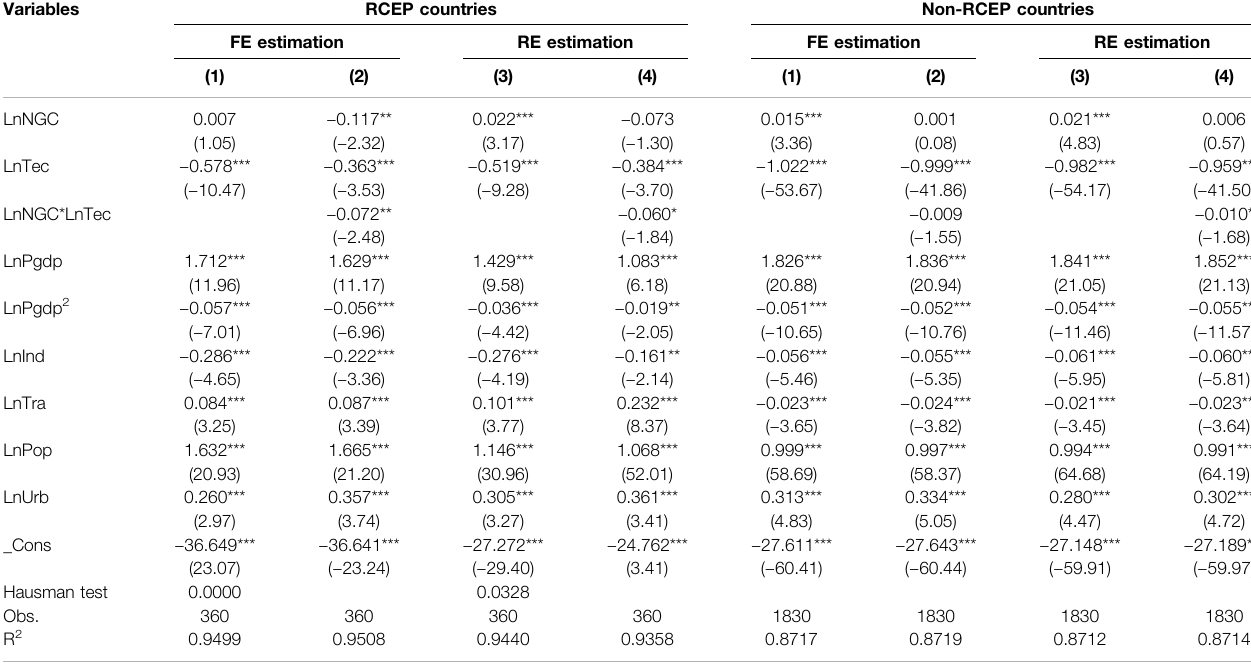
TABLE 6 | Results of the FE and RE estimates across the RCEP and non-RCEP countries. Variables RCEP